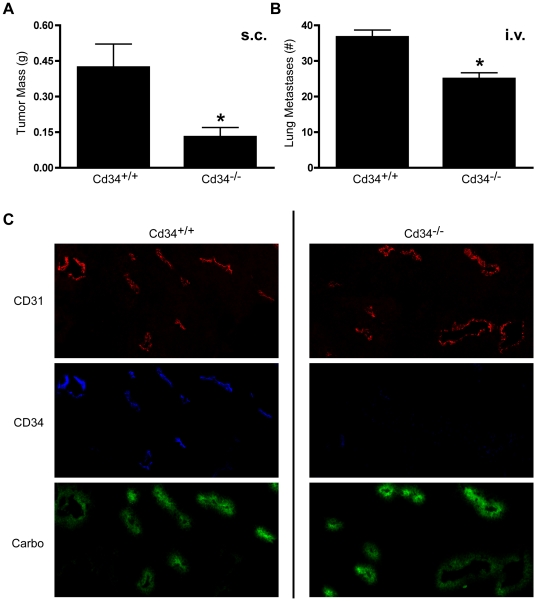
Melanoma growth is reduced in Cd34−/− animals at day 14, with CD34 expression on vasculature.A, Average tumor mass 14 days after subcutaneous injection of 5×105 B16F1-OVA cells. (Pooled from three experiments, Cd34+/+ n = 12; Cd34−/− n = 15). B, Average number of lung metastases 12 days after intravenous injection of 3×105 B16F1-OVA cells. (Cd34+/+ n = 5, Cd34−/− n = 6, *represents p<0.05; Error bars = SEM). C, Representative photomicrographs from s.c.-injected tumor sections stained for CD34 and CD31 or carbocyanine fluorescence, as indicated (CD31-red, CD34-blue, carbocyanine-green).